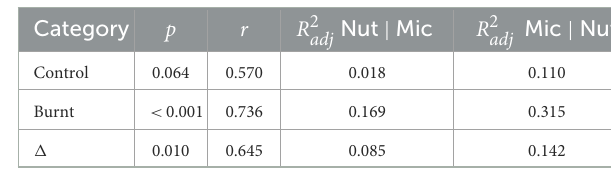
TABLE 5 Canonical correlation analysis was performed to compare nutrient and microbial datasets with p values for the entire model derived from the F -test of Pillai’s trace and Pearson’s r extracted as the correlation between the first pair of canonical